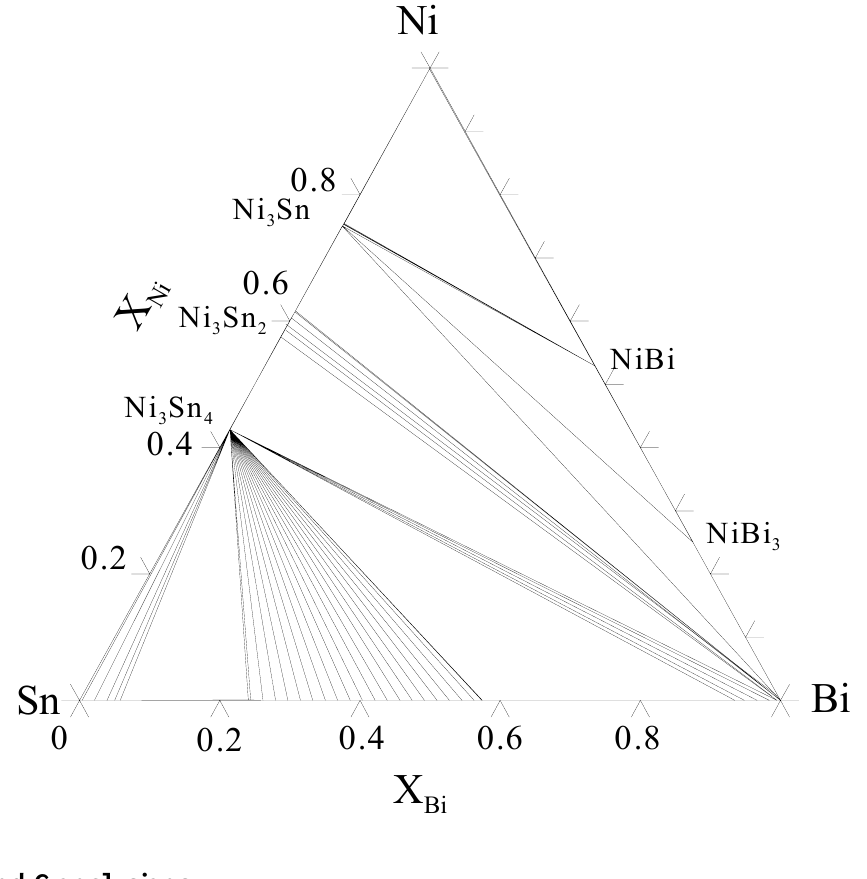
Figure 27. Isothermal section of the Bi-Ni-Sn system at 180